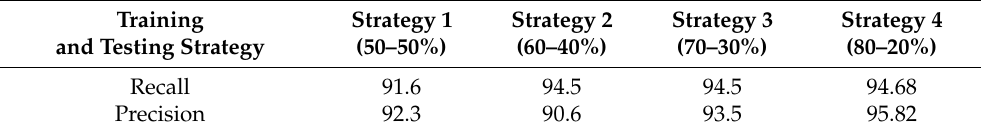
Table 14. Value for Recall and Precision at 4 different training and testing strategies for dataset 1 [43].